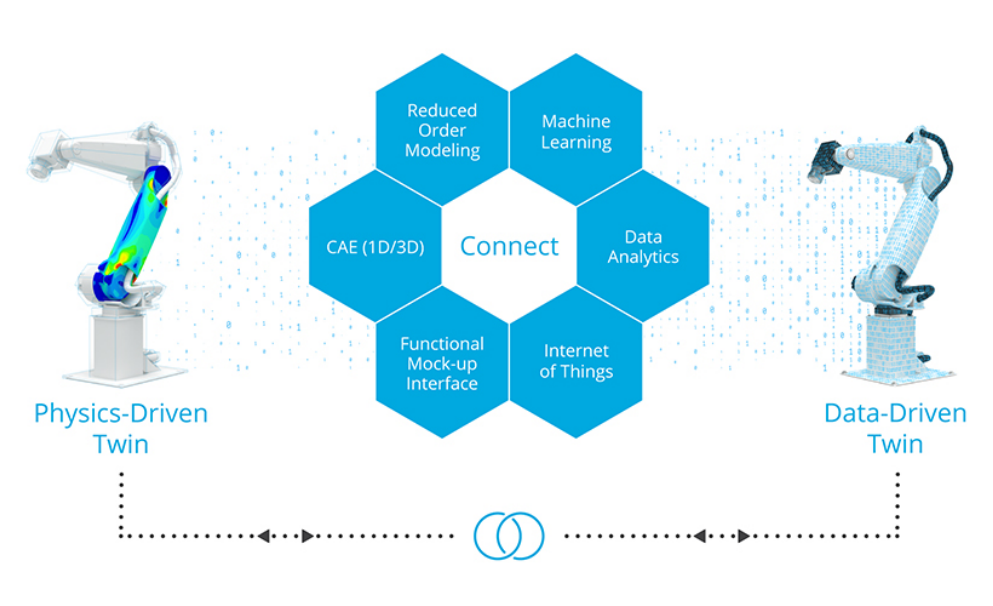
Figure 8. An illustration of DT in robotics: Altair digital twin platform [288].